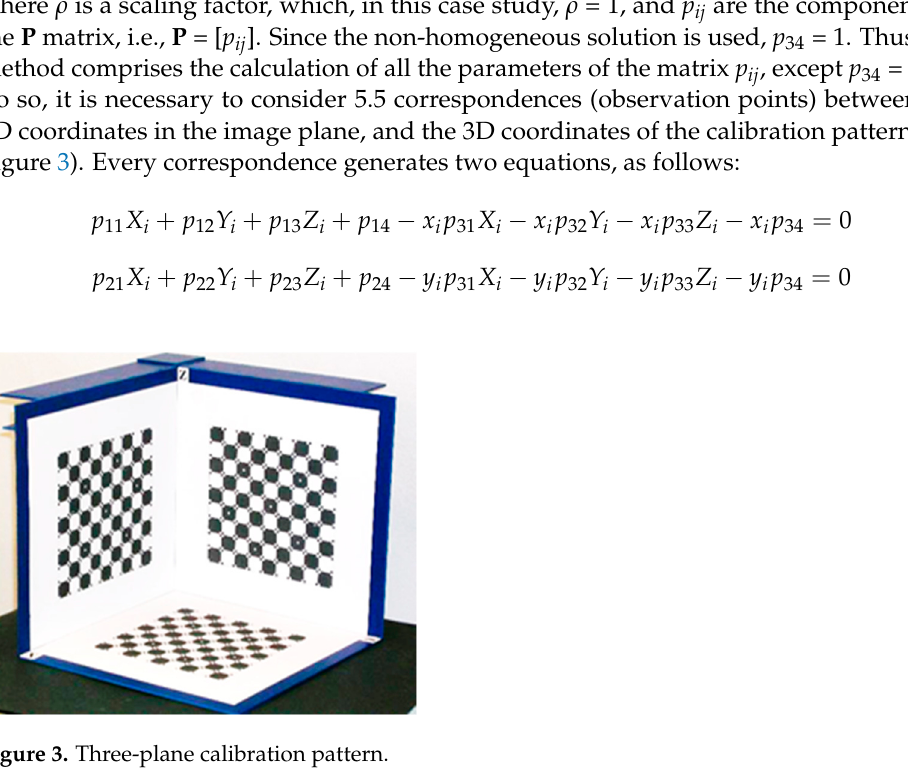
Figure 3. Three-plane calibration